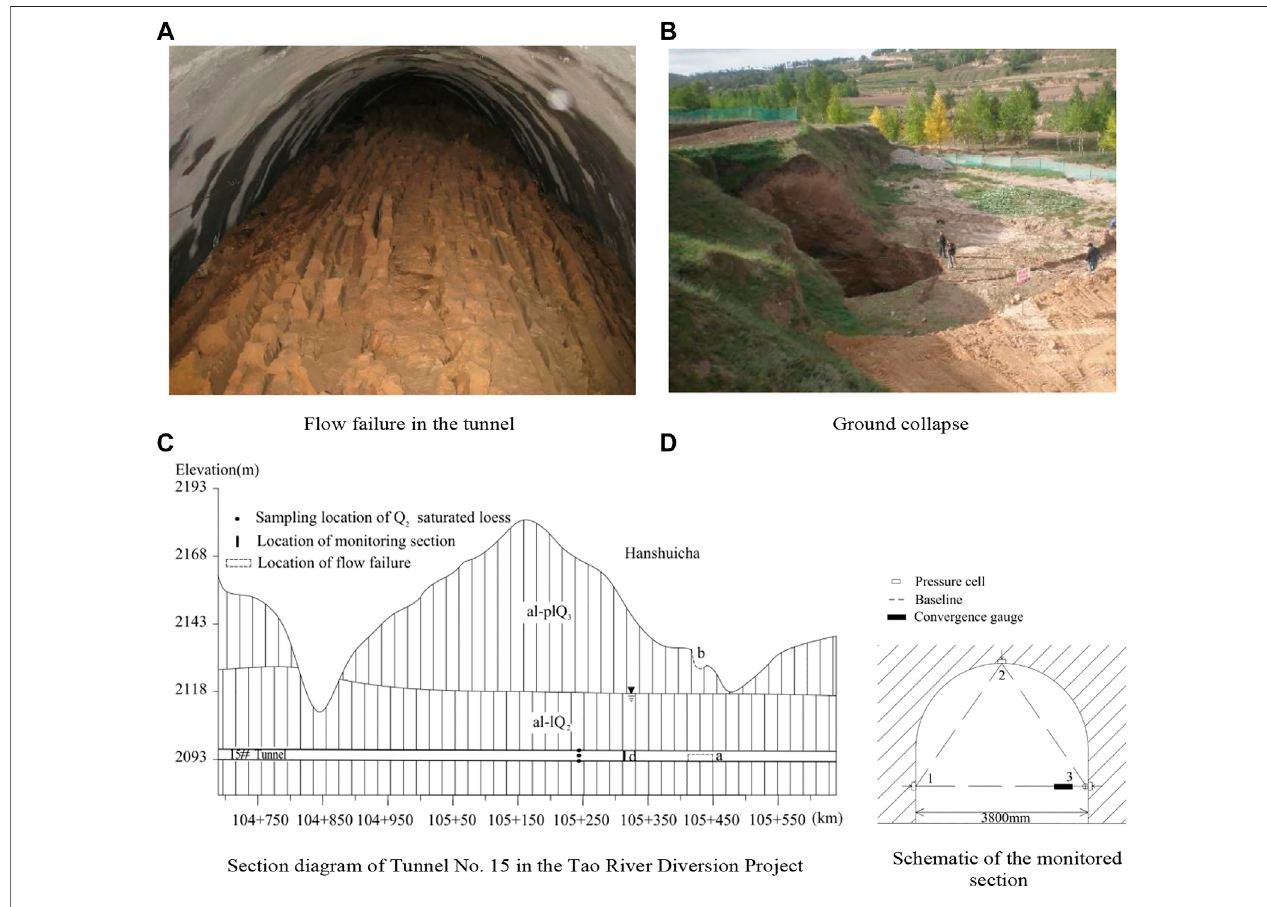
FIGURE 1 | Flow failure of saturated Q2 loess in Tunnel No. 15 of the Tao River Diversion Project. (A) Flow failure in the tunnel. (B) Ground collapse. (C) Section diagram of Tunnel No. 15 in the Tao River Diversion Project. (D) Schematic of the monitored section.